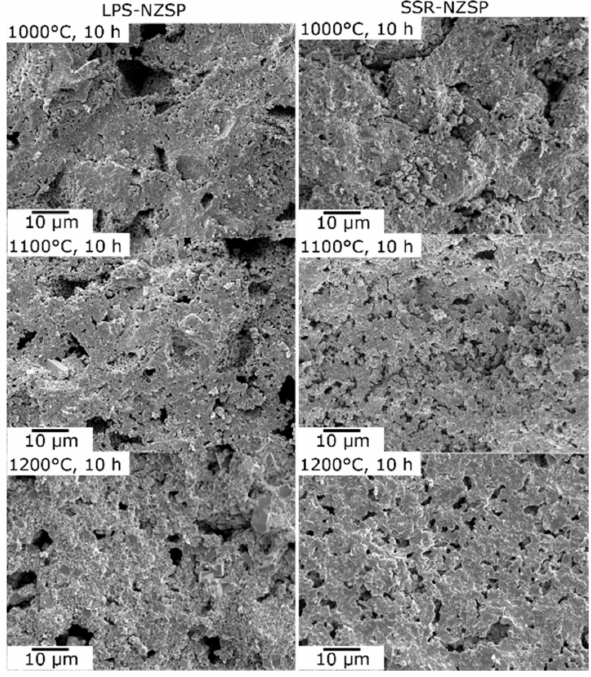
Figure 6. SEM cross-section observation of the